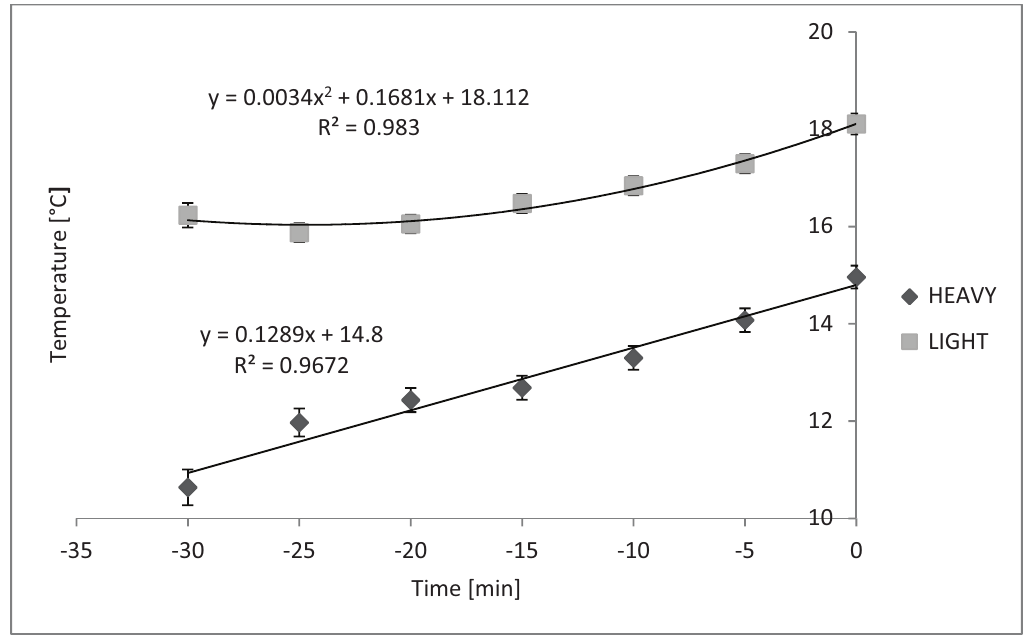
Figure 5. Time × bedding level effect on temperature while loading during mild weather ( P < 0.01). 0.6 m 3 (n = 13 trailers) and 1.2 m 3 or 2.4 m 3 (n = 9 trailers) bedding levels were used. 0.6 m 3 SEb < 0.01 and 1.2 m 3 or 2.4 m 3 = 0.11. There was a quadratic change in internal trailer temperature when light bedding was used and linear increase in internal trailer temperature when heavy bedding was used during loading in mild season/temperatures ( P = 0.04 and P < 0.01, respectively).